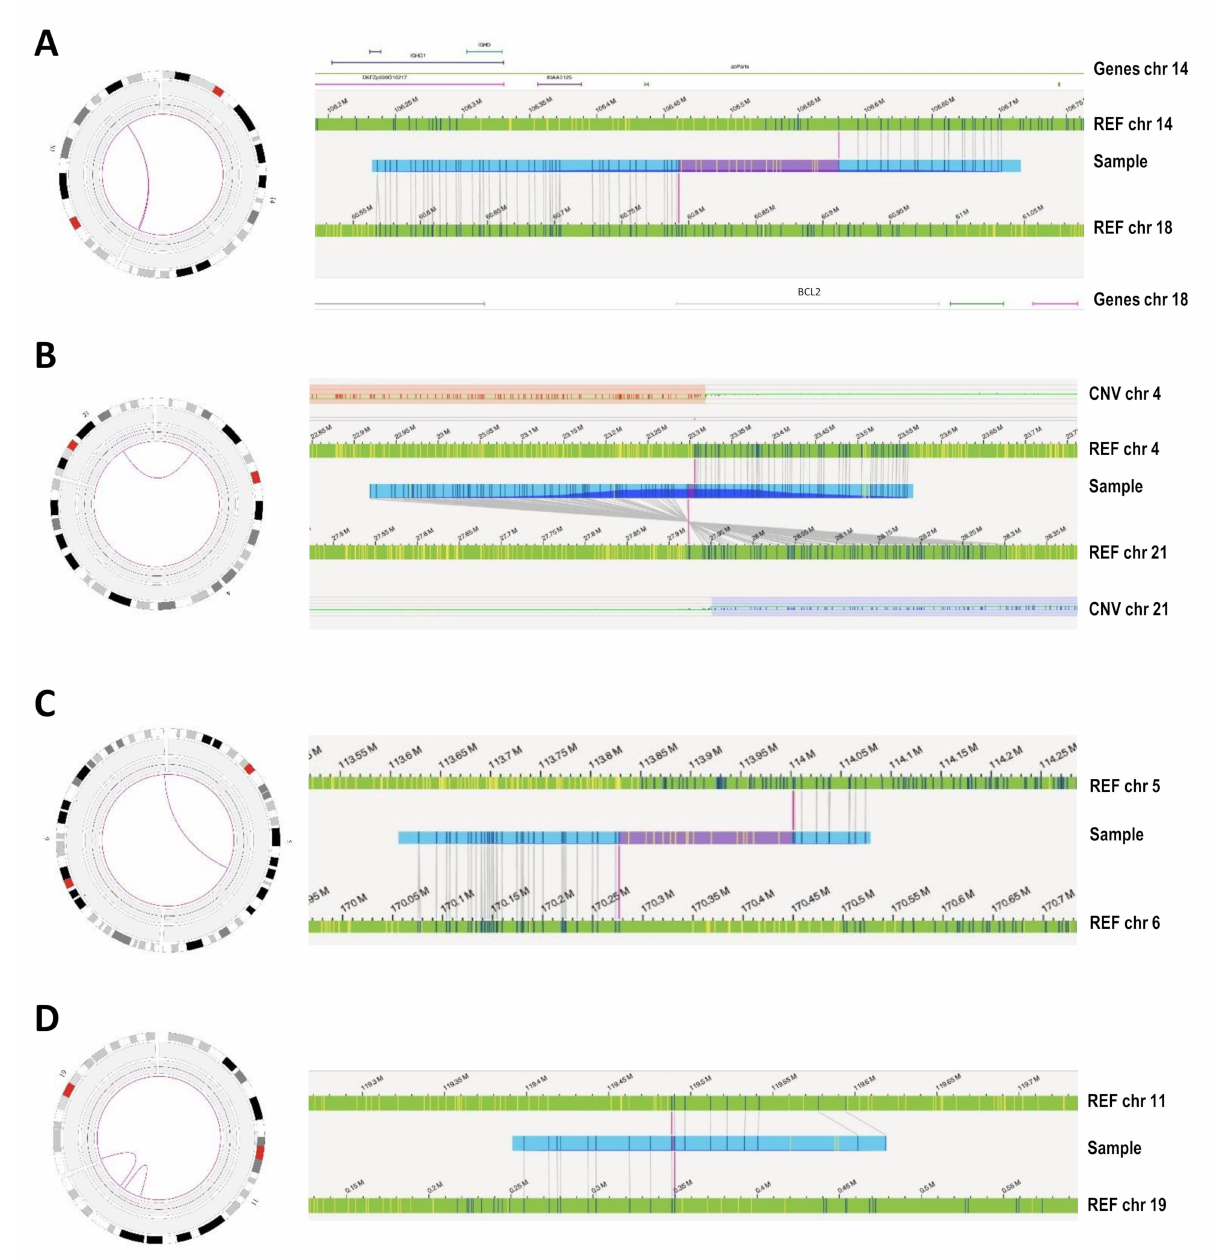
Figure 2. Examples of the Circos plots and genome map views showing two real and two non- validated interchromosomal translocations. Validated translocations displayed a high number of labels mapped on each chromosome involved in the rearrangement: ( A ) Previously known t(14;18)(q32;q21) from patient #16, in which OGM also correctly identified the involvement of the BCL2 and IGH genes in the rearrangement, and ( B ) t(4;21) with breakpoints at the limit of known CNV by CMA detected in patient #12, which corresponded to an unbalanced translocation that was cryptic in the karyotype and could be validated by WCP. On the contrary, images ( C , D ), representing a t(5;6) found in patient #3 and a t(11;19) from patient #13, were not validated by FISH using custom BAC probes for the specific rearrangements. These calls showed a low number of labels (<10) in at least one of the mapped chromosomes, which corresponded to the one showing low confidence score values. Of note, none showed breakpoints affecting regions provided by Bionano Genomics as DLE-1 masked (such as segmental duplications, common false positive regions or